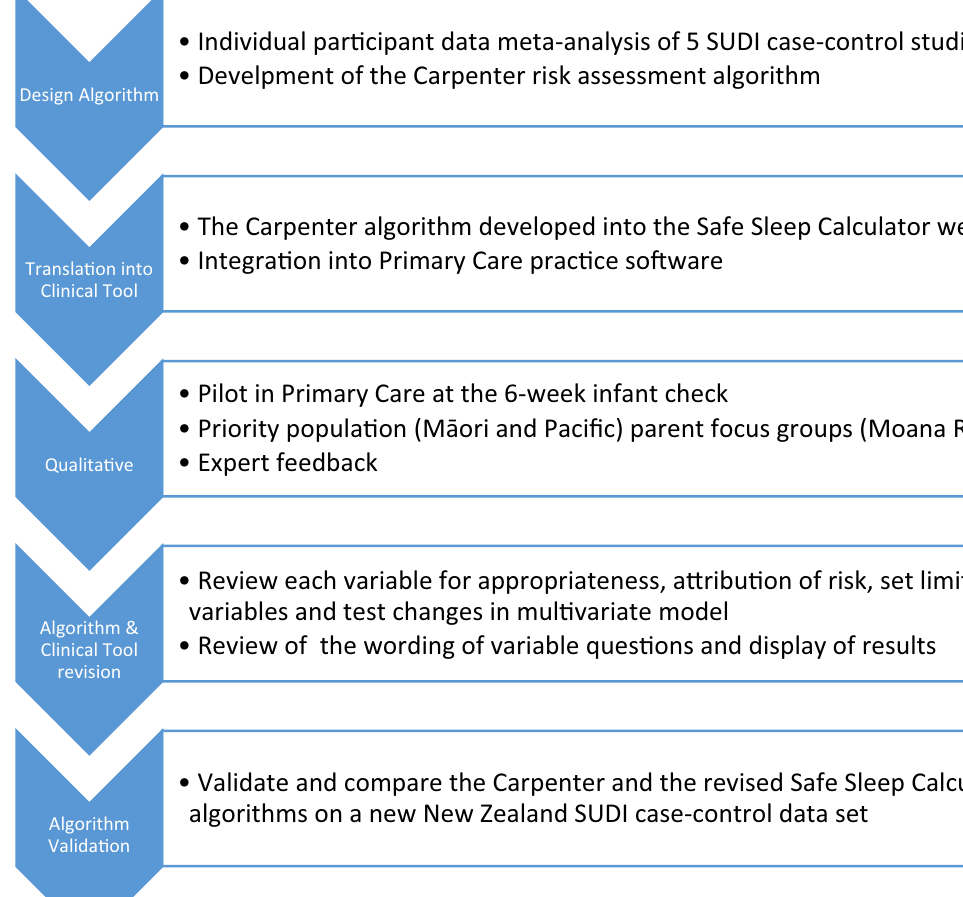
Figure 1. Study design showing the stages of translational research to develop, test and revise the Safe Sleep Calculator algorithm and clinical